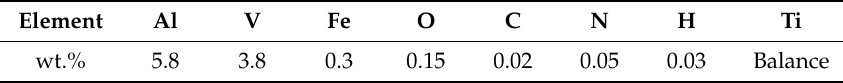
Table 1. The chemical composition of Ti-6Al-4V